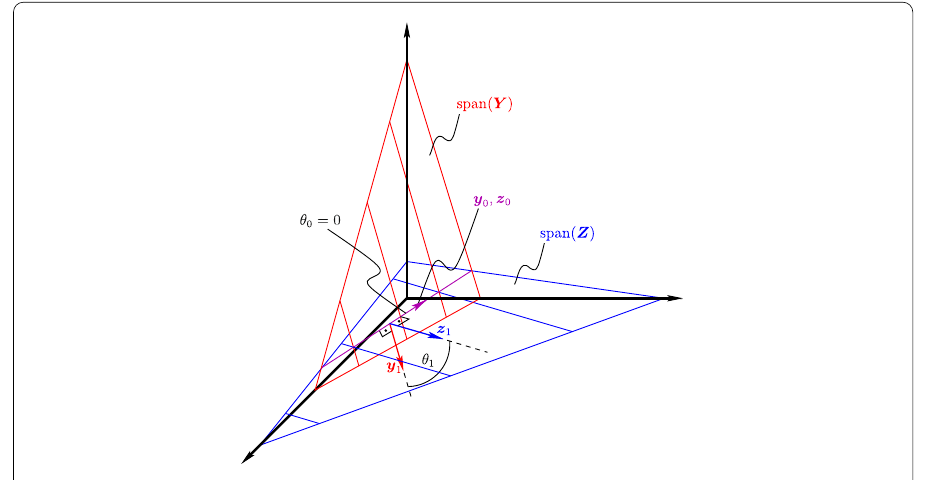
Fig. 3 Geometrical interpretation of subspace angles between 2D subspaces of a 3D space. The subspaces are defined by the column span of Y , Z ∈ R 3 × 2 in the current illustration. θ 0 and θ 1 are the two subspace